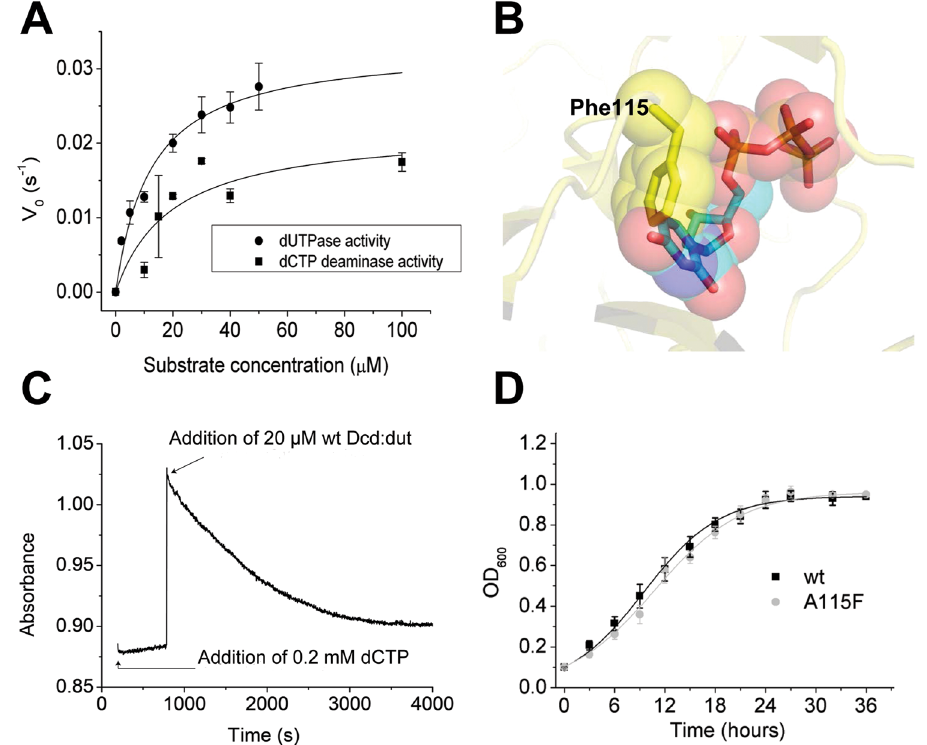
Figure 4. ( A ) Steady-state dUTPase and dCTP deaminase activity of wt Dcd:dut. The parameters yielded by fitting the Michaelis-Menten equation are shown in Table 1. The error represents the SD of 3 measurements. ( B ) The structural model of the active site of the M. tuberculosis Dcd:dut showing the steric conflict of the Phe115 side chain with the uracil ring of the substrate dUTP. ( C ) dCTP deaminase time course demonstrating the inactivity of the A115F Dcd:dut mutant. At t = 0, dCTP was added to a premix containing 0.02 mM A115F Dcd:dut. During ~500 s incubation time, no reaction (i.e. absorbance decrease) was detectable. The time course obtained upon the addition of the wt Dcd:dut enzyme confirmed that the assay was functional. ( D ) In vitro growth analysis of wt and Dcd:dut mutant M. smegmatis strains. The strains were grown in Lemco broth in shaking cultures for 2 days at 37 °C. Growth curves were prepared from (3 * 3) independent colonies from each mutation; means ± SD are plotted. Fitting the y = a/(1 + exp( − k * (x − xc))) equation to the curves yielded the following a, xc and k values: 0.94, 9.5 and 0.22 for the wt and 0.96, 10.8 and 0.19 for the A115F dcd:dut mutant